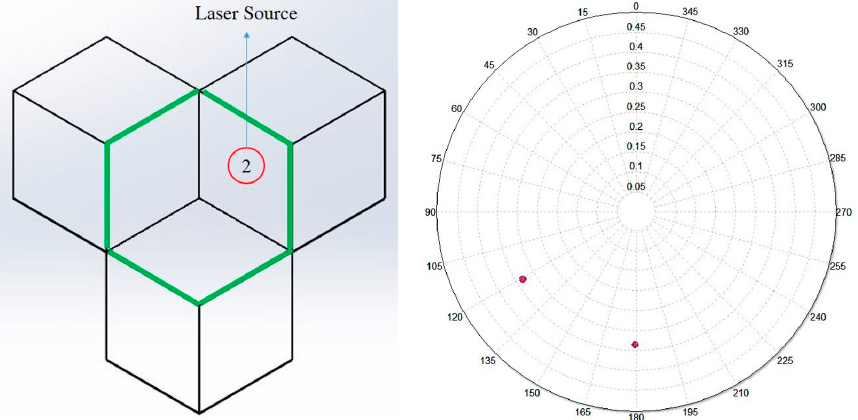
Figure 14. CCCR #2 reflecting surface in the posterior region is hit by simulated laser beam ( left ) and the resulting retroreflected light intensity distributions ( right ).